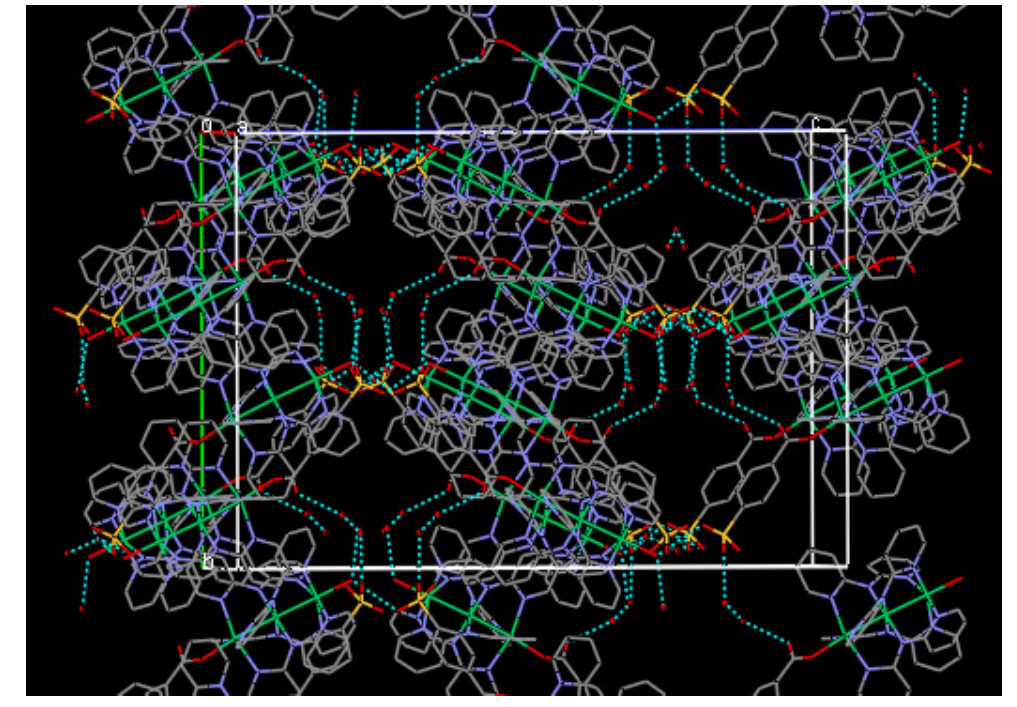
Figure 2. View of the 3-D hydrogen-bonding architecture of 1 .